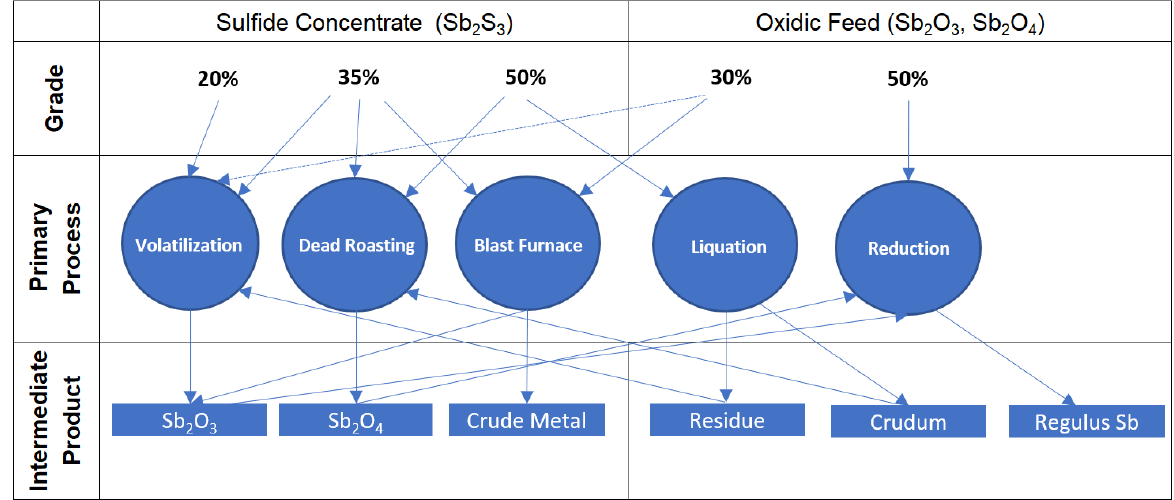
Figure 3 . Process selection for treatment of antimony ores (adapted from [54]). Figure 3. Process selection for treatment of antimony ores (adapted from